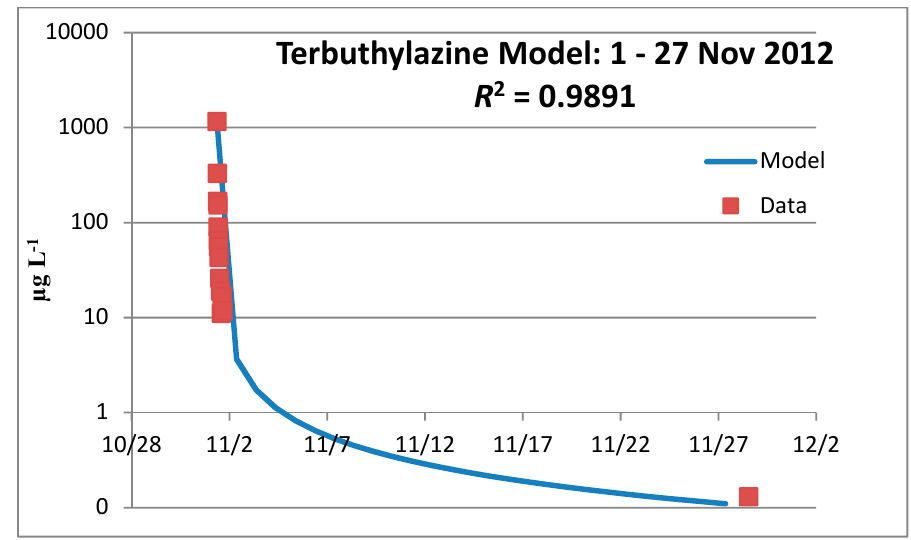
Figure 6. Streamflow terbuthylazine residue decay curve regression for Year 1 based on the data from the sub ‐ catchment trial [30].